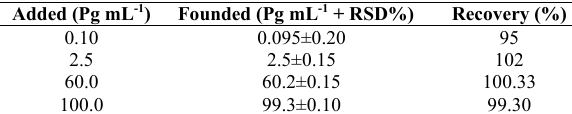
Table 1 . Detection of HCG in real samples. Table 1. Detection of HCG in real